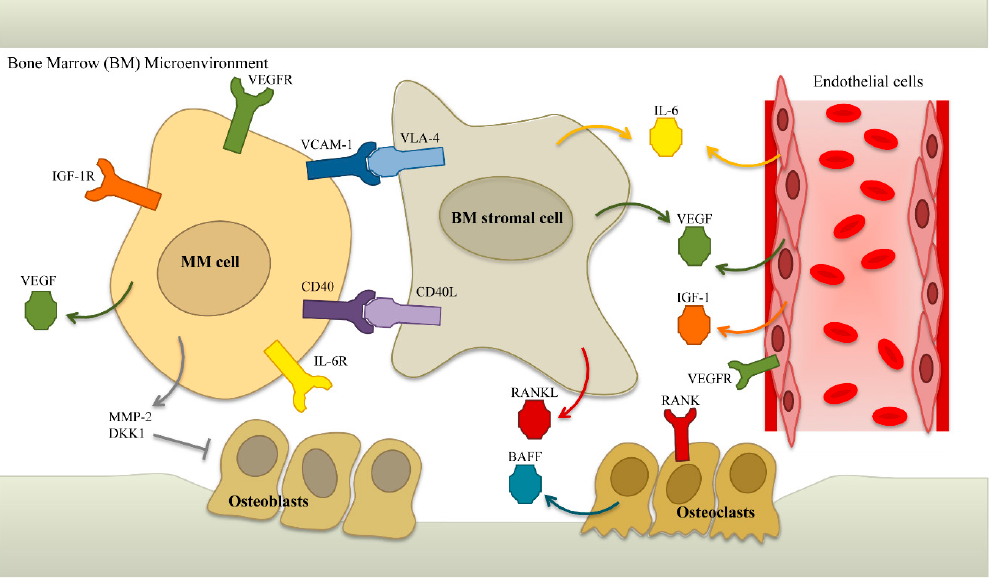
Figure 1. Interactions between multiple myeloma (MM) cells and the bone marrow (BM) niche. Adhesion of MM cells to BM stromal cells is mediated by cell-adhesion molecules including vascular cell adhesion molecule-1 (VCAM-1) and integrin α -4 (VLA-4). This adhesion triggers secretion of cytokines, such as VEGF and IL-6, from both MM cells and BM stromal cells. Both of these cytokines stimulate the growth of MM cells and development of the neo-vasculature. Endothelial cells, in turn, secrete more VEGF, IL-6, and IGF-1, further enhancing growth and survival of MM cells. Furthermore, receptor activator of NF κ B ligand (RANKL) is produced by BM stromal cells and stimulates osteoclastogenesis. In contrast, osteoblast differentiation is inhibited by Dickkopf-1 (DKK-1), which is produced by MM cells. MM cells also secrete metalloproteases, such as MMP-2, resulting in degradation of the BM niche. While inhibition of osteoblastogenesis promotes osteolysis, degradation of the BM environment further enhances homing of the MM cells.